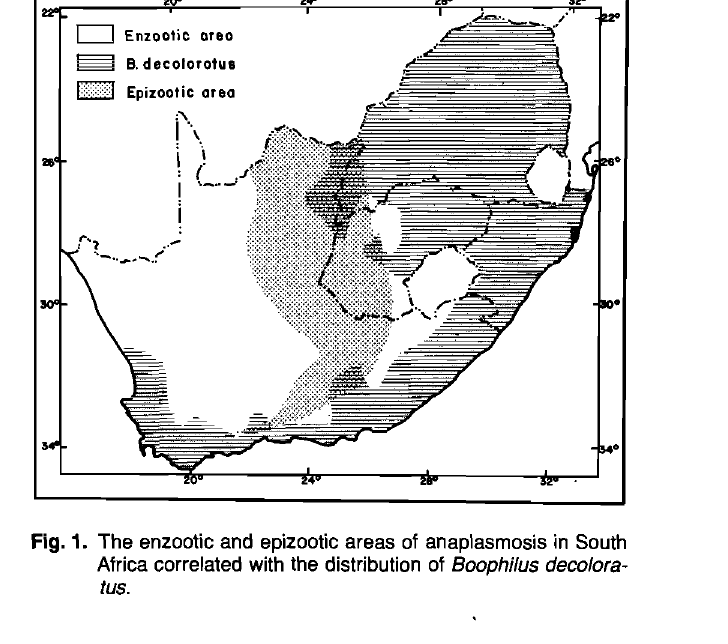
Fig. 1. The enzootic and epizootic areas of anaplasmosis in South Africa correlated with the distribution of Boophilus decolora